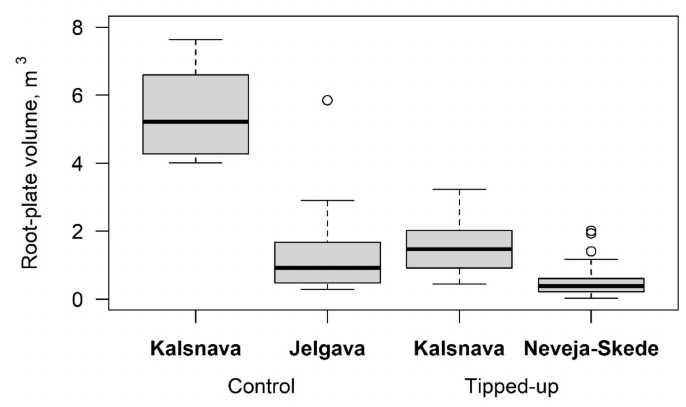
Figure 2. Root-plate volume of tipped-up trees and control (tree-pulling test) in two di ff erent soil types: